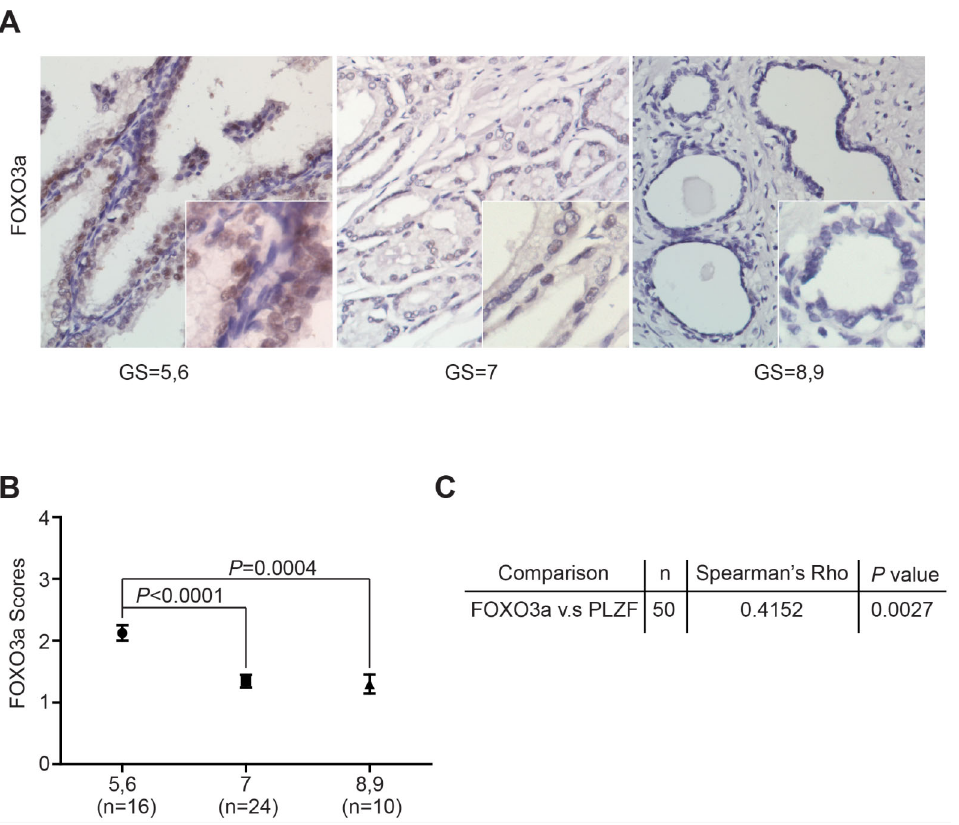
Figure 5. FOXO3a expressions in prostate cancer tissues. A. The representative immunohistochemical staining for FOXO3a of human prostate cancer specimens of low (GS=5, 6), moderate (GS=7) and high grades (GS=8, 9) by the Gleason score. Scale bar, 50 m m. B. The mean staining scores of FOXO3a was evaluated in low, moderate and high grades of prostate cancer specimens. Data were shown as mean 6 SD. The P values for comparison between line-linked groups were gotten by Student’s t -test. C. The Spearman correlation of FOXO3a and PLZF expression to each other was illustrated.